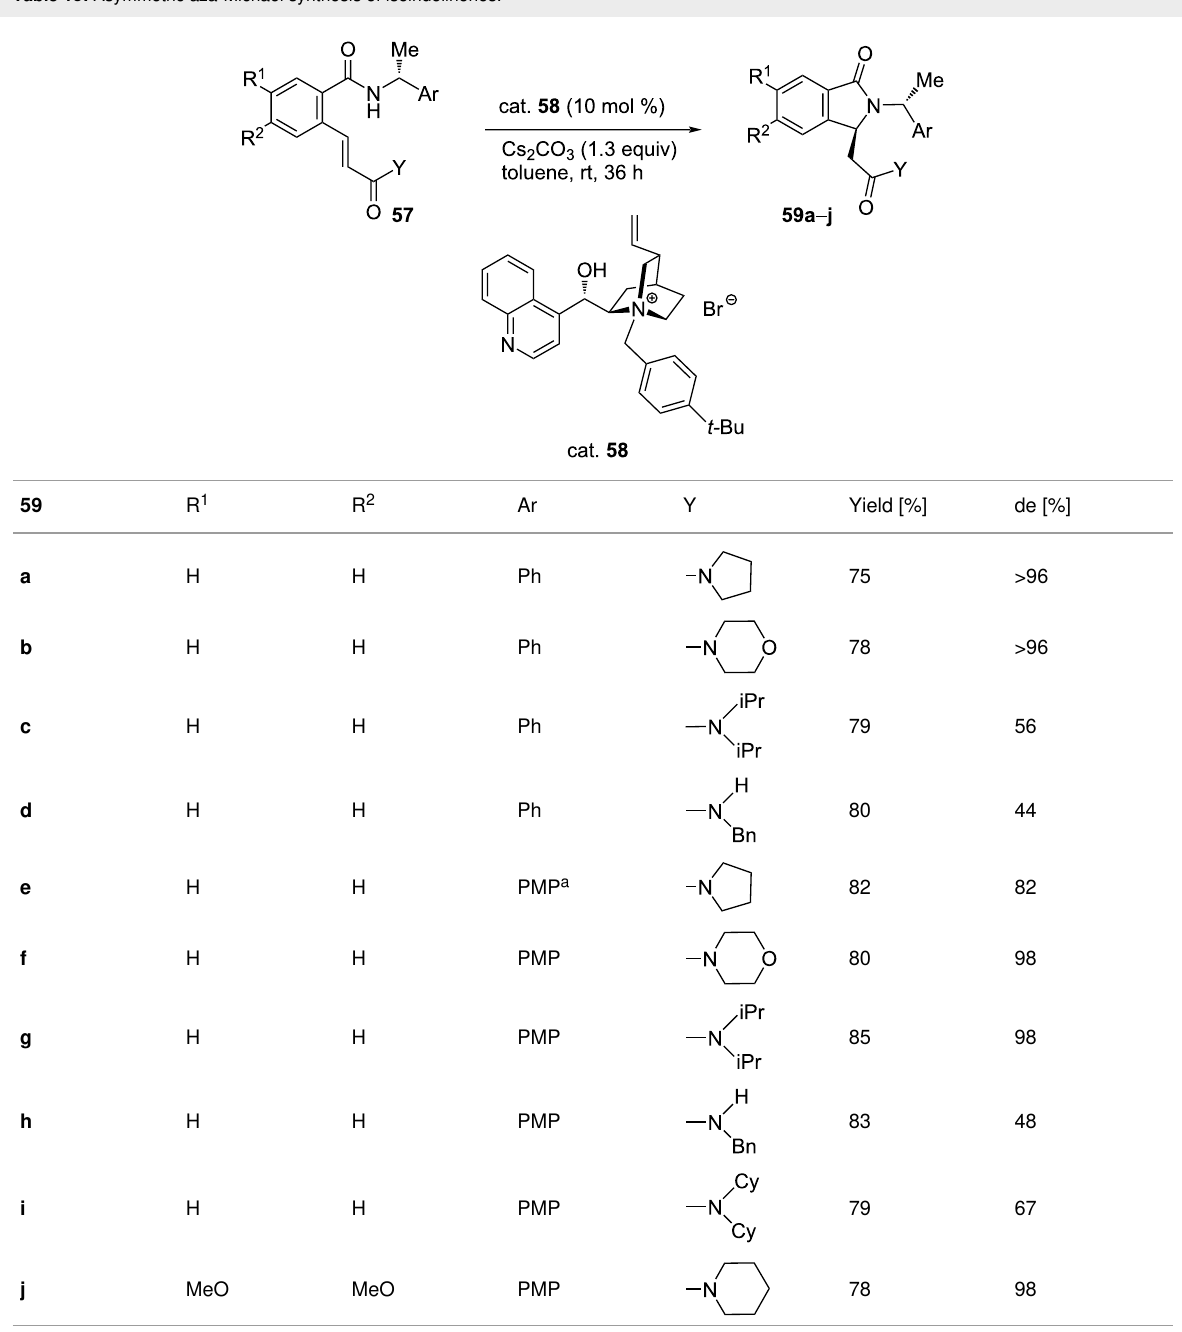
Table 13: Asymmetric aza-Michael synthesis of